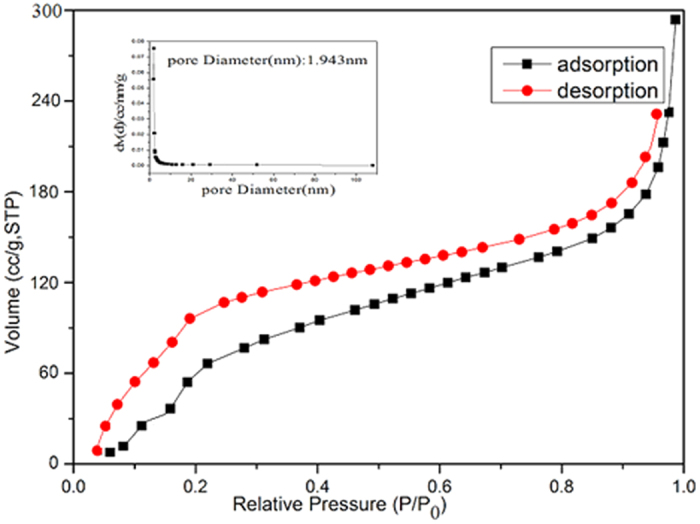
N2 adsorption/desorption isotherm (77K) curve for hollow porous magnetic Fe3O4@NH2-MIL-101(Fe).